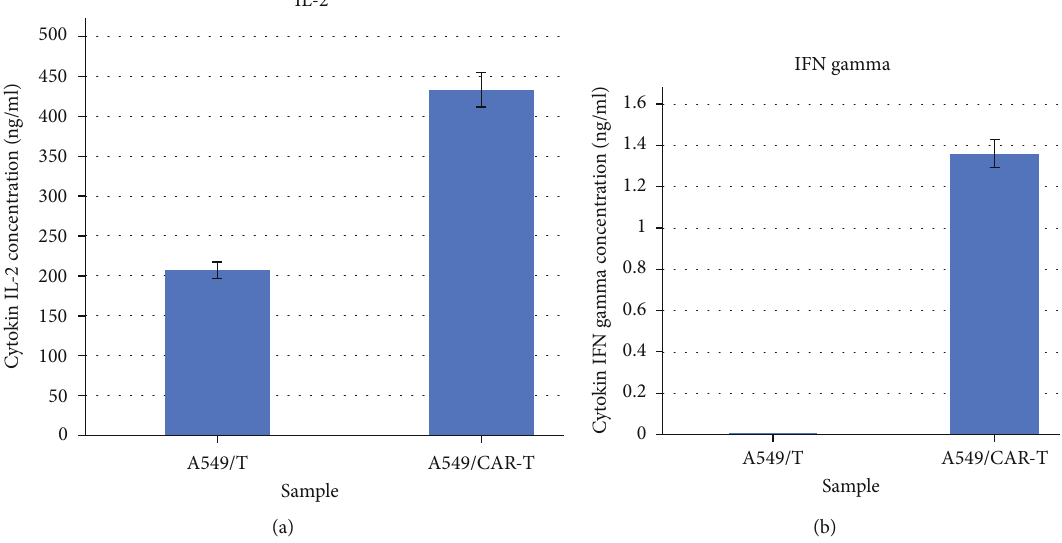
Figure 5: (a) IL-2 and (b) IFN gamma secretion of CAR-T and T cell when interacting with cancer cell lines